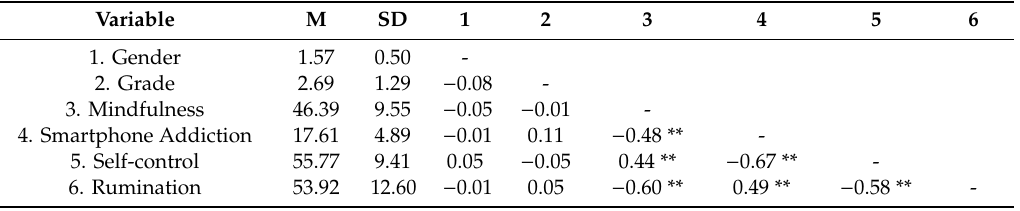
Table 1. Means, standard deviations and correlations among the key study